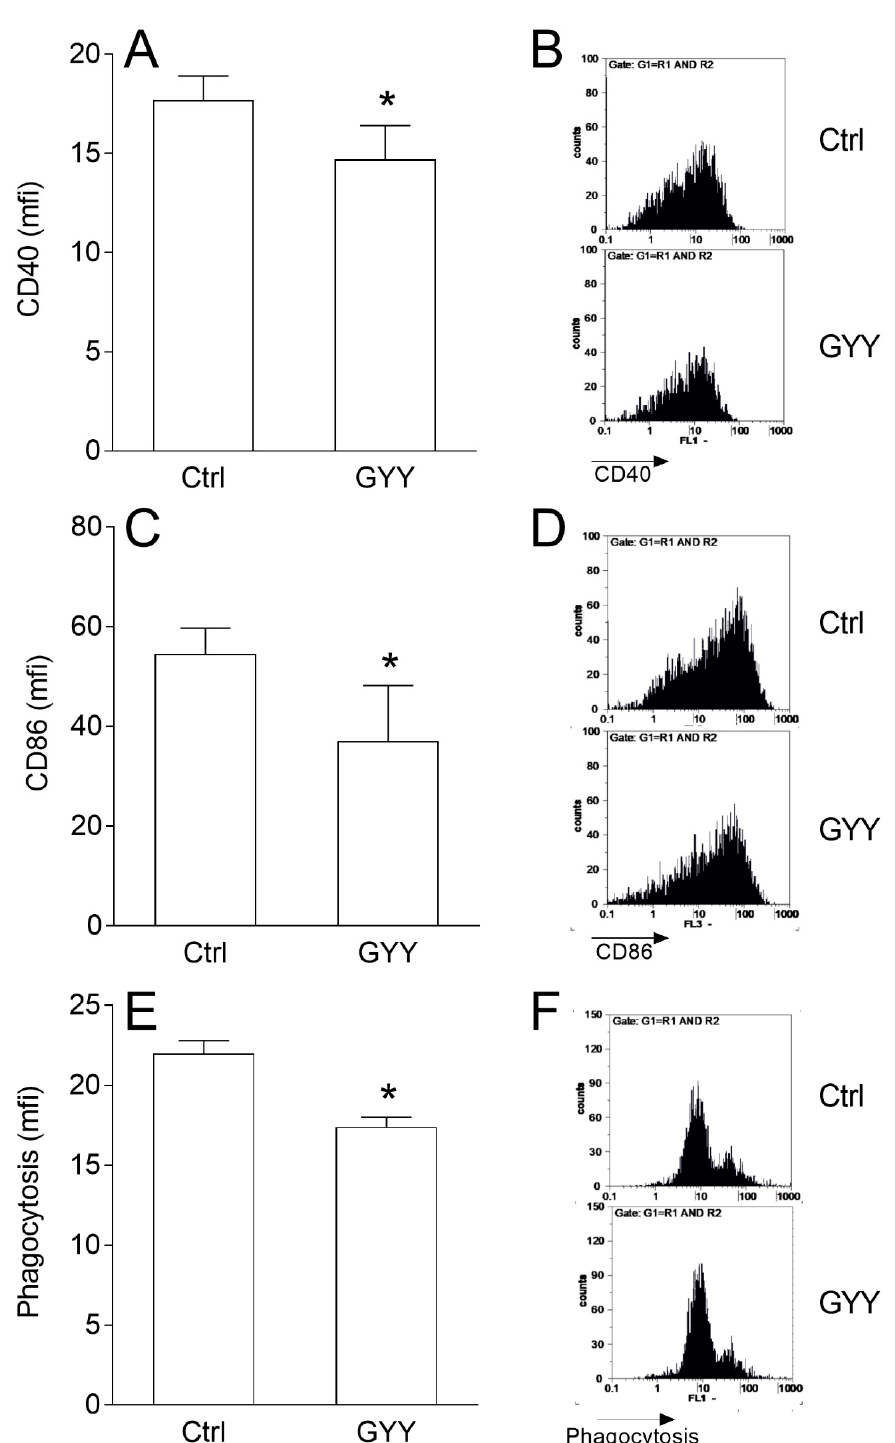
Figure 2. Effects of GYY4137 (GYY) on phenotype and phagocytosis in BV2 cells. BV2 cells were stimulated with IFN- γ and LPS and cultivated in the presence of DMSO (Ctrl) as the vehicle or GYY (200 µ M) for 24 h. Subsequently, expression of CD40 ( A , B ), CD86 ( C , D ), and phagocytosis ( E , F ) were determined by cytofluorimetry. Data are presented as mean + SD from at least three independent experiments ( A , C , E ). Representative plots are also provided ( B , D , F ). * p < 0.05 refers to Ctrl.